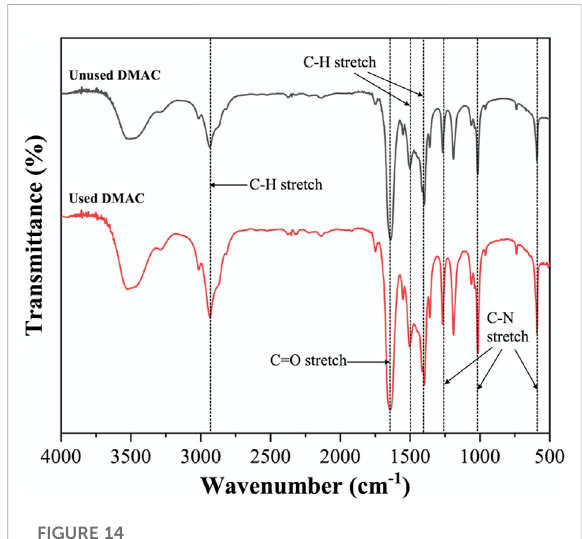
FIGURE 14 FTIR spectra of the unused DMAC and used DMAC ( fi